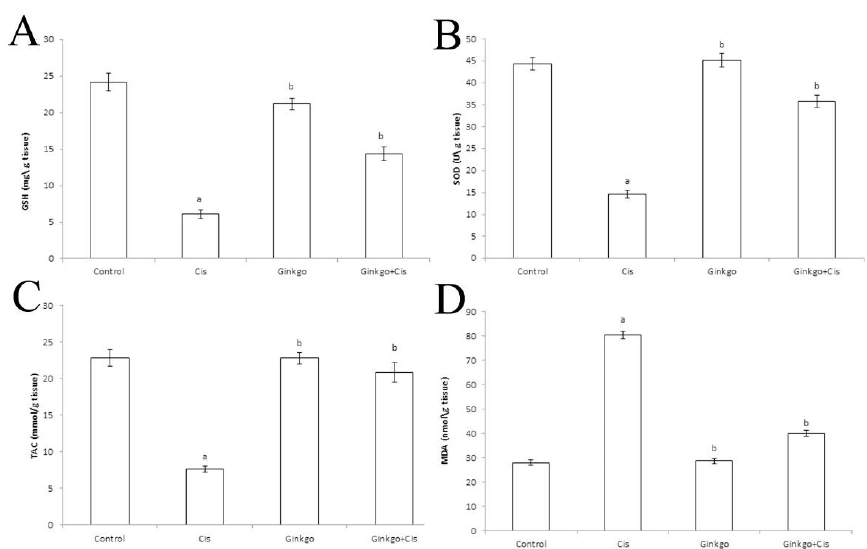
Figure 3. The changes of oxidant/antioxidant parameters of different groups. The Effect of Cis, Ginkgo, and their combination on reduced glutathione (GSH) ( A ), super oxide dismutase (SOD) ( B ), Total antioxidant capacity (TAC) ( C ) and Malondialdehyde (MDA) ( D ). Data were presented as mean ± SE ( n = 10). a indicates a significant difference compared to control group, b indicates a significant change compared to Cis group. a and b indicate statistical significance at p < 0.05 using ANOVA followed by Tukey–Kramer as a post ANOVA test.